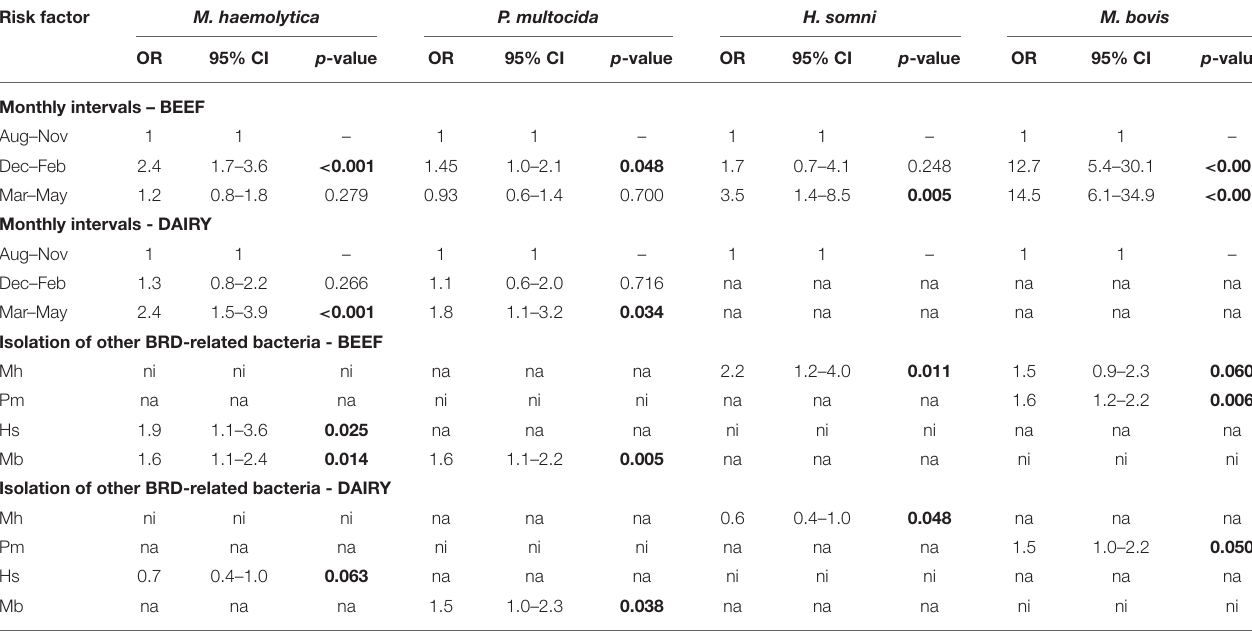
TABLE 4 | Significant results obtained from logistic regression of recovery of bovine respiratory disease complex bacteria from beef and dairy-type cattle upon feedlot arrival. Risk factor